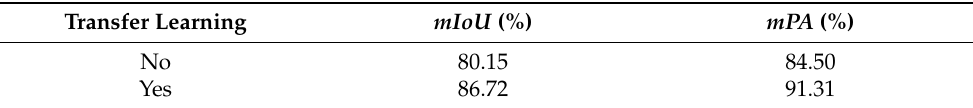
Table 1. A comparison of the transfer learning results.